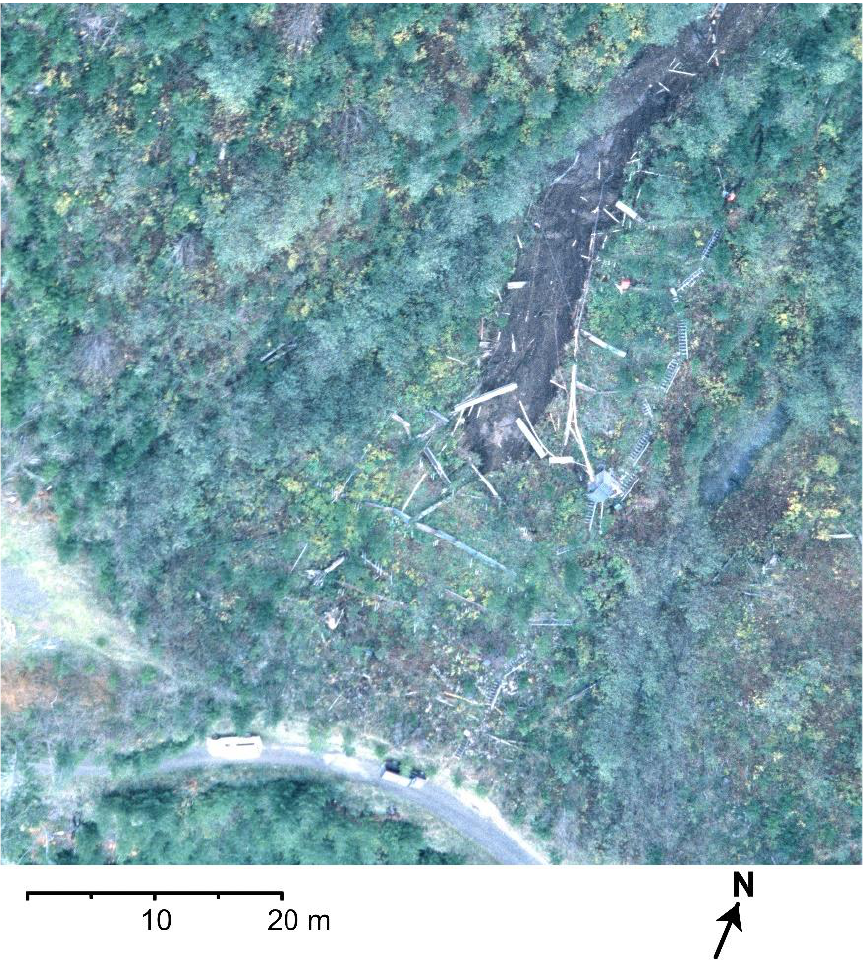
Figure 1. Post-landslide oblique aerial photo, taken roughly towards the NNW direction, reveals both upslope shallow landslide extent and downslope debris flow scour. Vehicles on the road near the bottom of the image indicate the relative size of the landslide area. Photograph by K.M. Schmidt, U.S. Geological Survey.